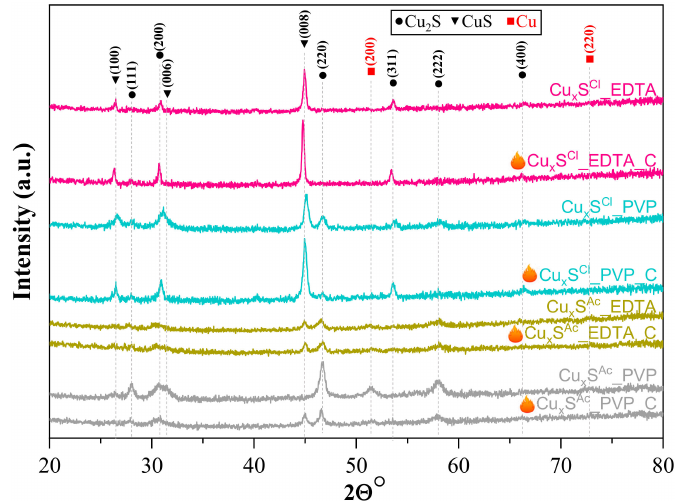
Figure 4. XRD patterns of all samples, showing the di ff raction peaks of the materials ( • Cu, (cid:72) CuS and (cid:4) Cu 2 S) in the sample, indicating the results of XRD measurements after the heat treatment.